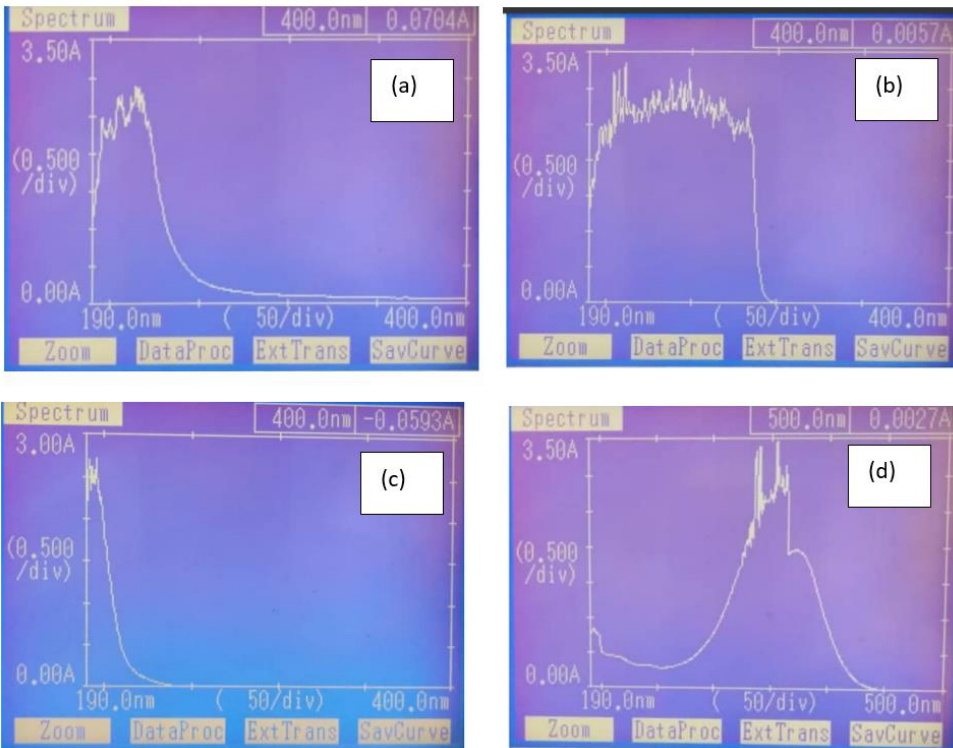
Figure 1. UV-Vis spectra of ( a ) clindamycin phosphate, ( b ) imidazolidinyl urea ( c ) methyl paraben, ( d ) tretinoin.